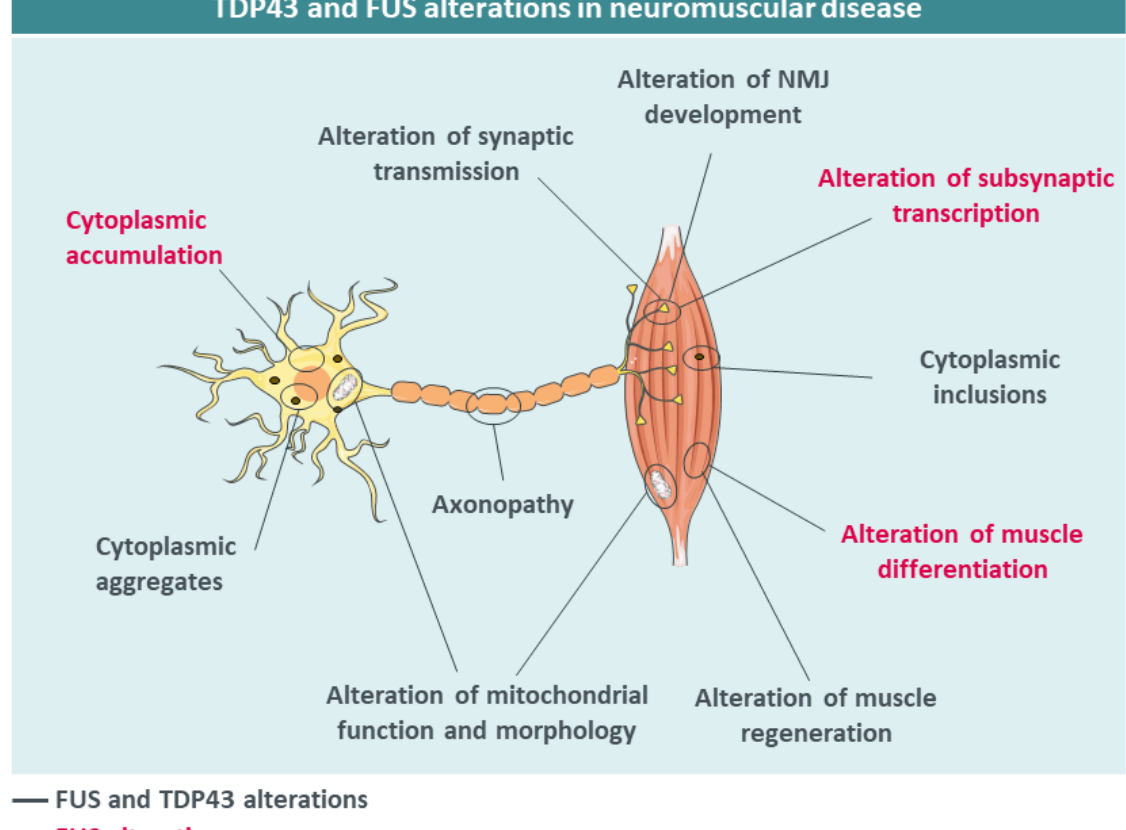
FIGURE 2: TDP43 and FUS alterations in neuromuscular diseases. Mutant TDP43 aggregates are found in motor neurons and muscles of patients. TDP-43 mislocalization causes axonopathy and mitochondrial alterations, alters synaptic transmission, NMJ development and mus- cle regeneration. Similar observations are made for FUS, which is also involved in subsynaptic